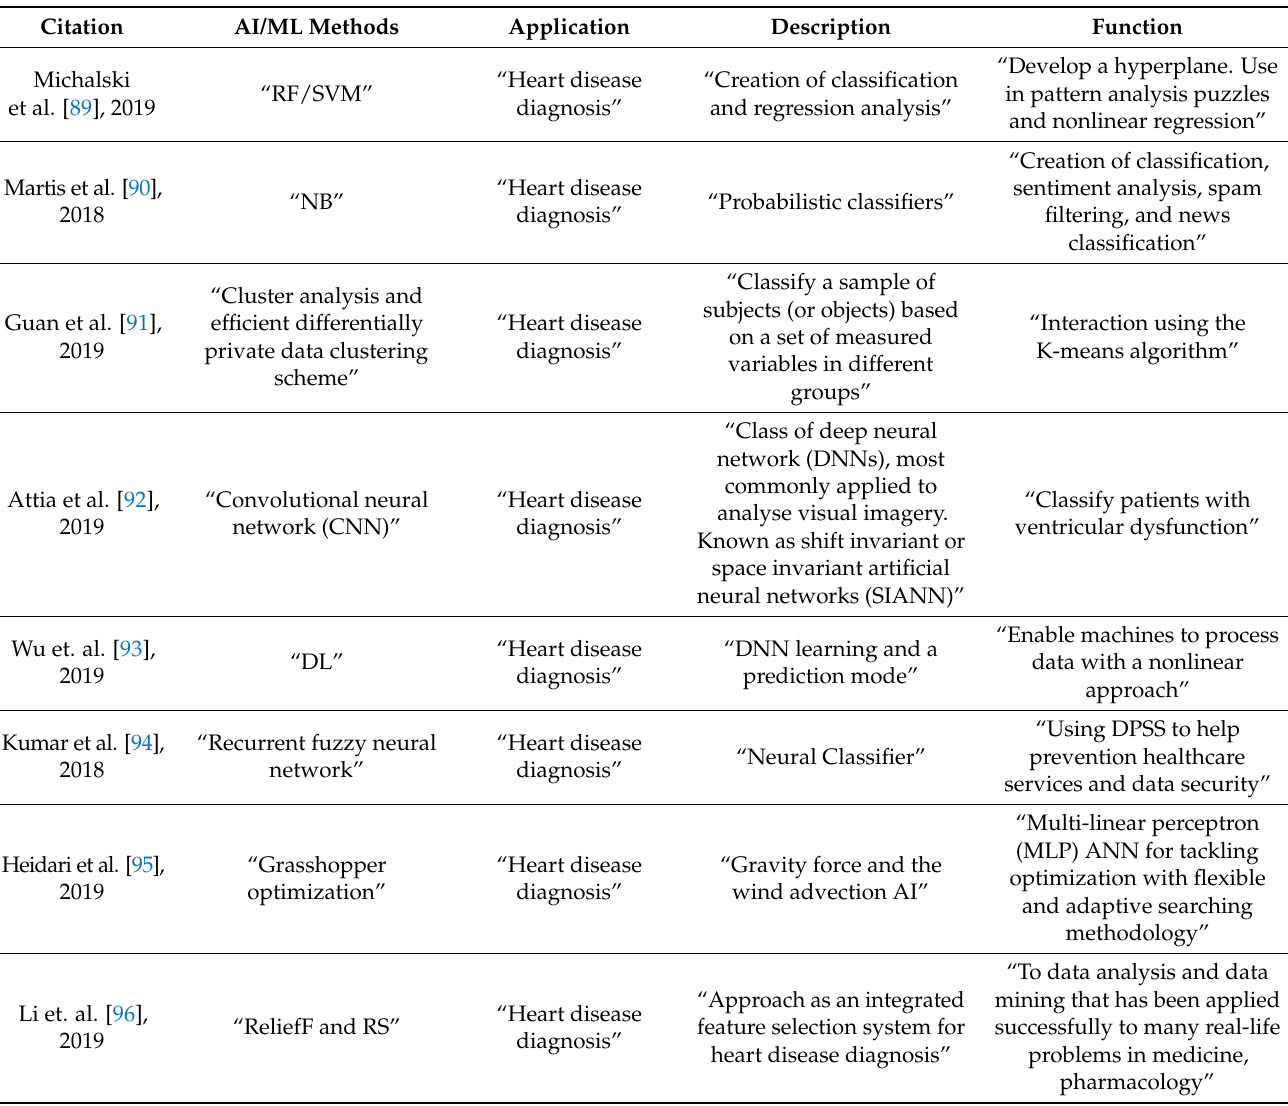
Table 4. AI/ML methodology for IoT and vital signs